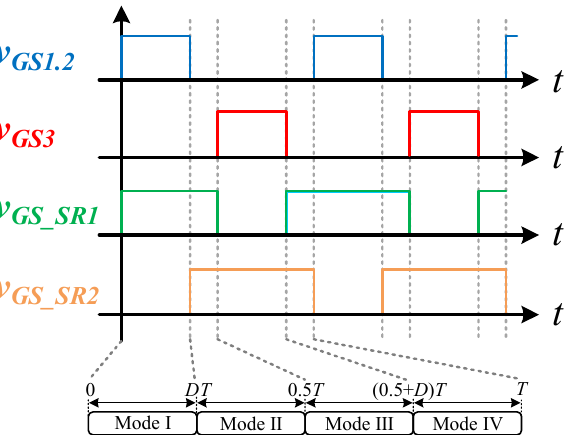
Figure 6. The switching sequence of the proposed topology.